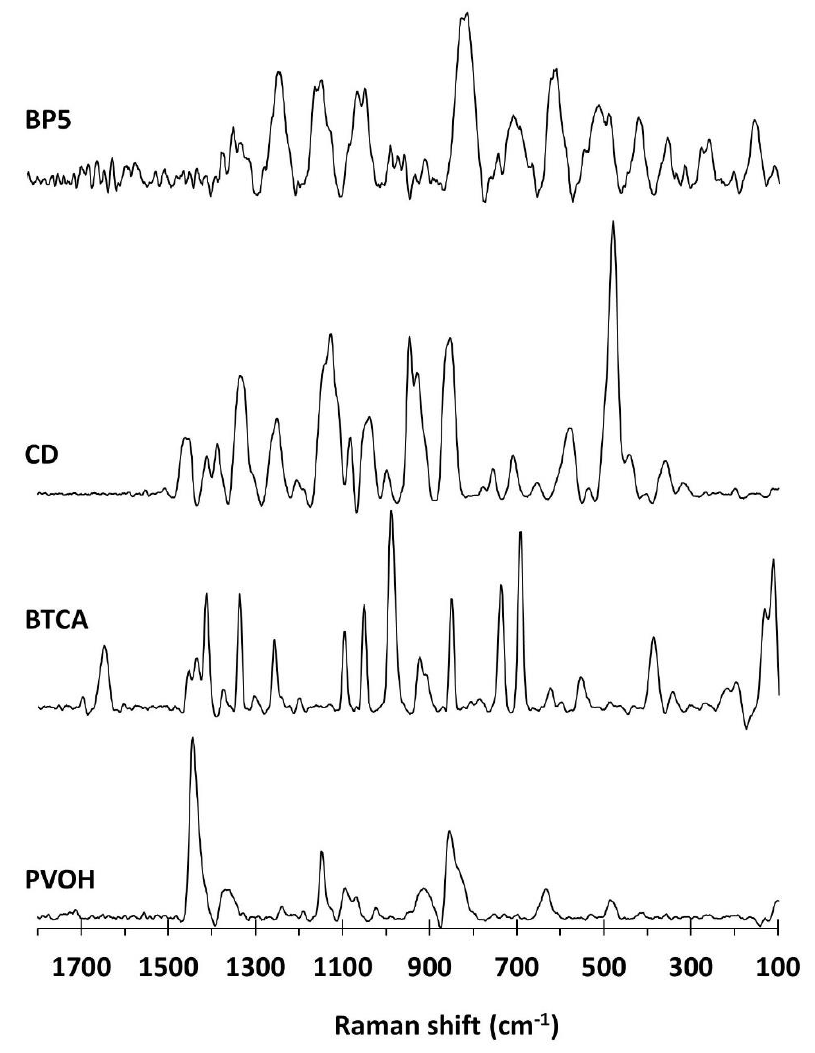
Figure 4. Raman spectra of β -CD, BTCA, PVOH, and BP5 nanosponges.